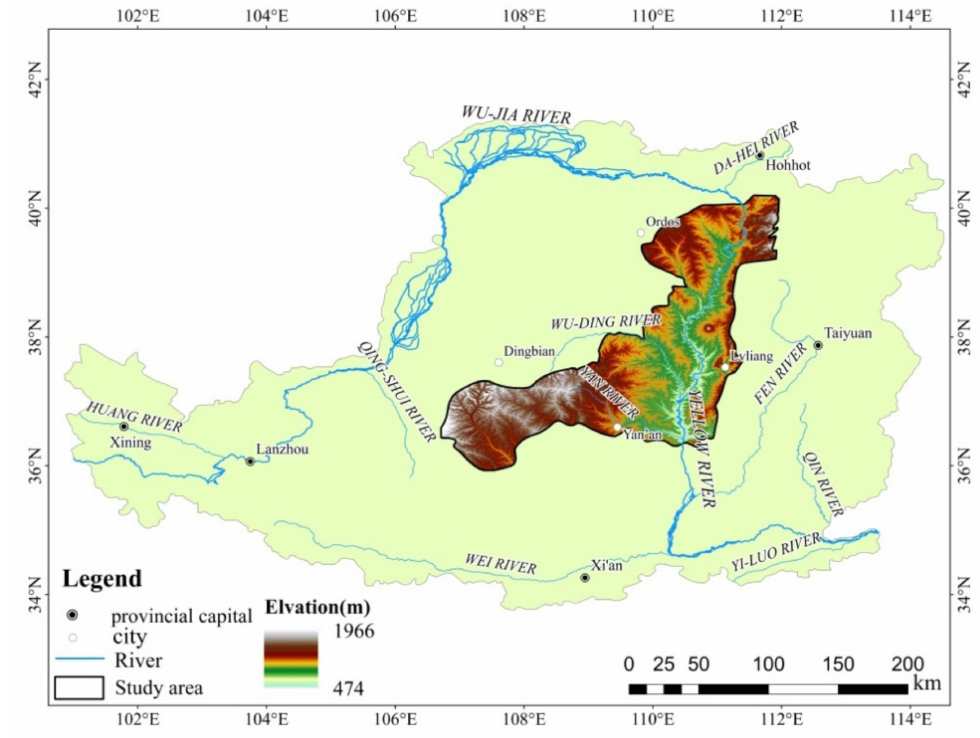
Figure 1. The areas with high and coarse sediment yield in the middle reaches of the Yellow